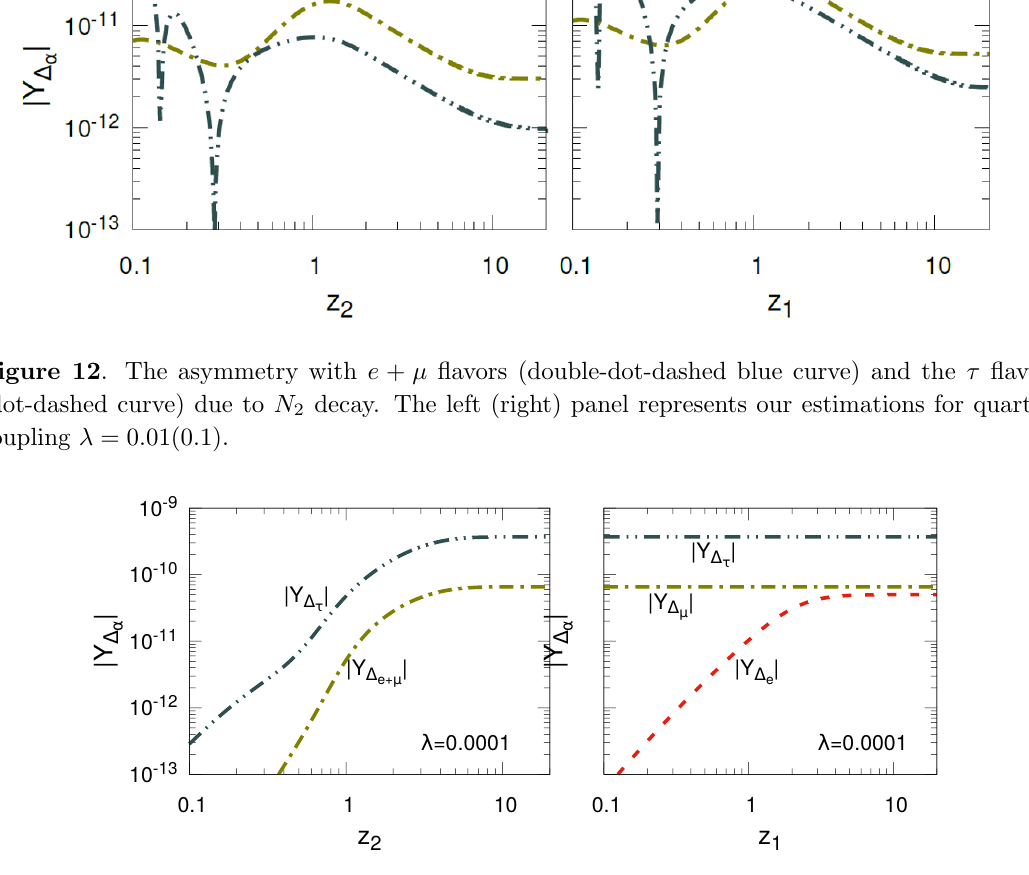
Figure 13 . The (cid:13)avor asymmetries in e + (cid:22) and (cid:28) (cid:13)avors (left panel) and separately for e , (cid:22) and (cid:28) (cid:13)avors (right panel). The quartic coupling has been (cid:12)xed at (cid:21) = 0 :